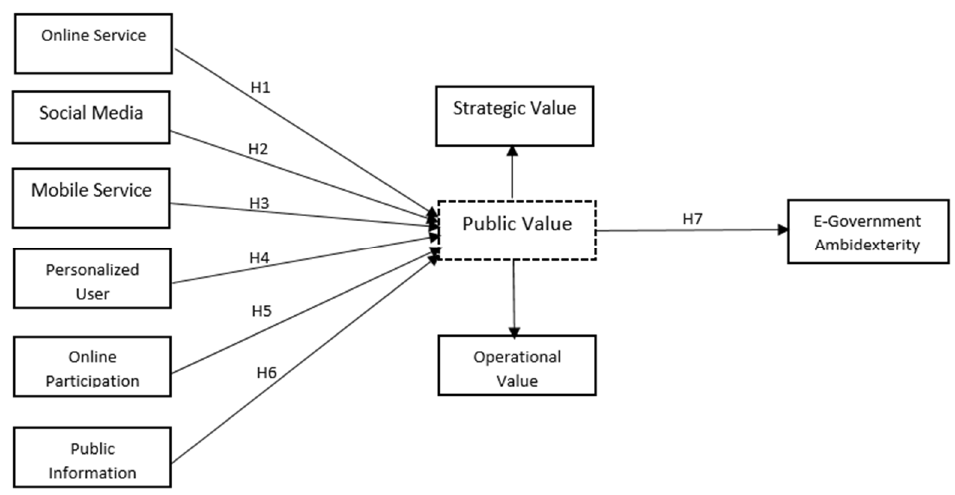
Figure 1. Research design and hypothesis development. Note: Online Service (OS); Social Media (SM); Mobile Service (MS); Personalized User (PU); Online Participation (OP); Public Information